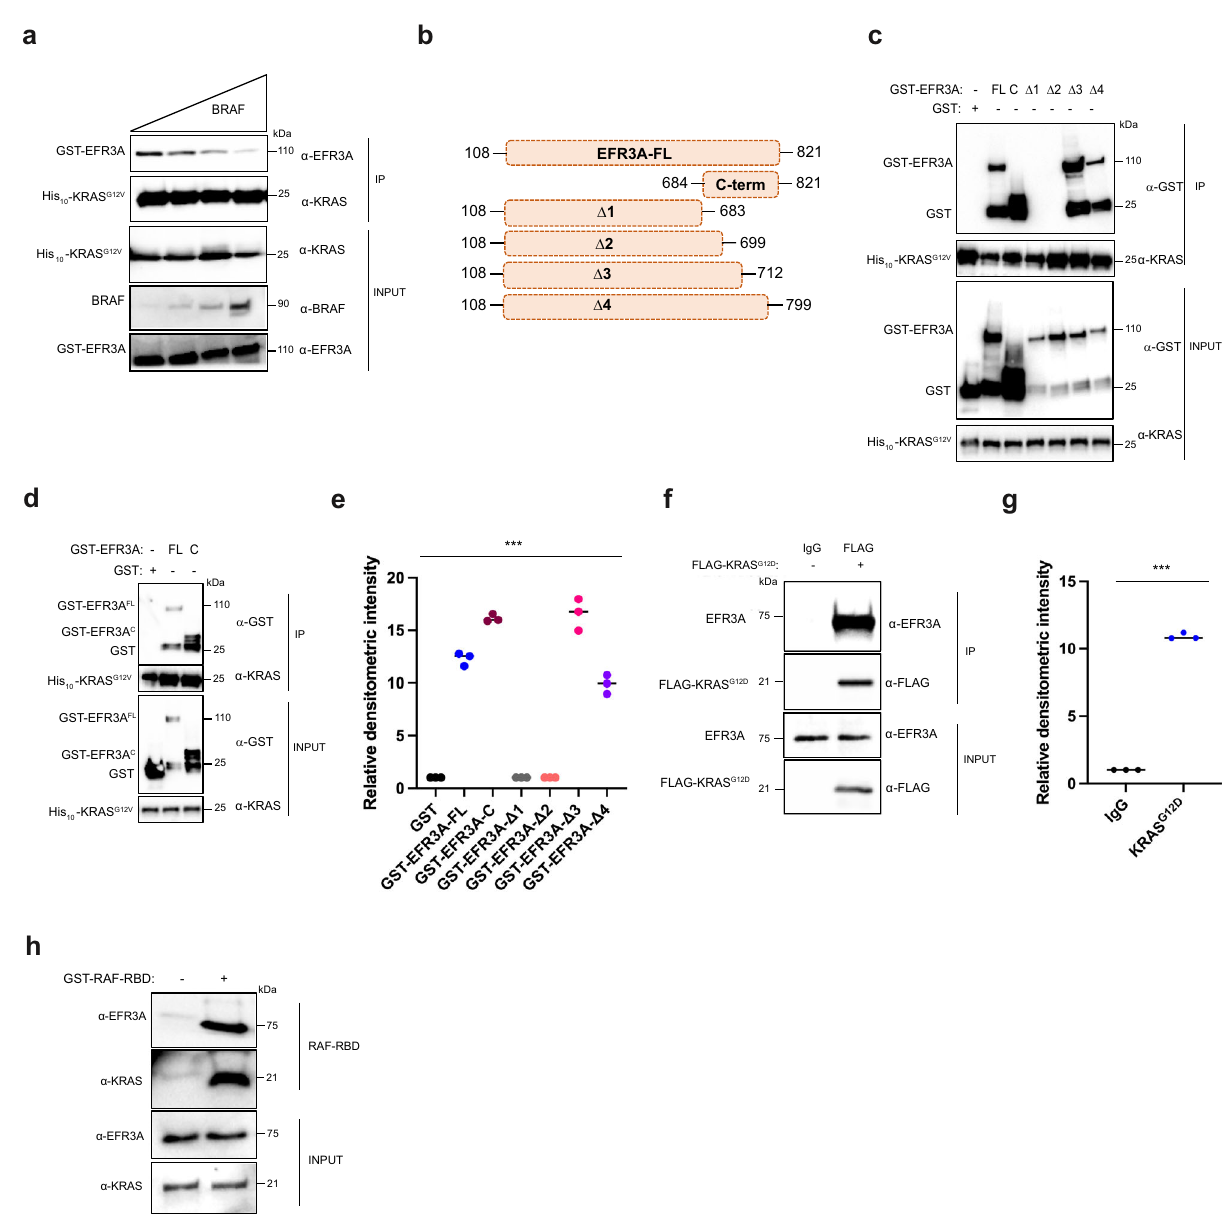
Fig. 5 EFR3A associates with recombinant and endogenous oncogenic RAS. a Analysis of levels of recombinant GST-EFR3A, as detected by immunoblot with an anti-EFR3A antibody, that co-immunoprecipitates (CO-IP) with recombinant His 10 -KRAS G12V (preloaded with GTP γ S) using an anti-KRAS antibody, in the presence of increasing levels of the RBD of BRAF, detected with and a BRAF-speci fi c antibody. INPUT levels are shown as loading controls. b – e A ( b ) schematic of GST-EFR3A constructs used (FL: EFR3A base construct lacking 1-107 residues, C: C-terminal fragment, Δ : C-terminal truncations of FL) and ( c , d ) the levels and ( e ) quanti fi cation thereof of the indicated recombinant GST-EFR3A proteins, as detected by immunoblot with an EFR3A-speci fi c antibody, co-immunoprecipitating (CO-IP) with recombinant His10-KRAS G12V (preloaded with GTP γ S) using a KRAS-speci fi c antibody. INPUT and IP serve as loading controls. GST serves as a negative CO-IP control. f , g Analysis of the ( f ) levels and ( g ) quanti fi cation thereof of the endogenous EFR3A, as detected by immunoblot with an EFR3A-speci fi c antibody, co-immunoprecipitating (CO-IP) with FLAG-KRAS G12D using a FLAG-speci fi c antibody when transiently expressed in 293T cells. h Levels of endogenous EFR3A bound to endogenous active KRAS, as assessed by RBD pull-down assay in AsPC-1 cells, as assessed by incubating AsPC-1 cell lysate with recombinant GST-RAF-RBD protein, followed by immunoblot with a KRAS-speci fi c antibody to detect active KRAS and an EFR3A-speci fi c antibody to detect endogenous EFR3A. INPUT and IP levels are shown as loading controls. a , c – h Representative of 3 biological replicates. Replicate experiments and full-length gels are provided in Supplementary Fig. 12. Signi fi cance values calculated by one-sided student ’ s t test for ( e , g ): *** p < 0.001. Speci fi c p values for ( e ) are 0.00052 (FL), 0.00035 (C), 0.00011 ( Δ 1), 0.00014 ( Δ 2), 0.00056 ( Δ 3), and 0.00034 ( Δ 4) and ( g ) is 0.00087. Targeting KRAS to the plasma membrane by an alternative illustrates that proteins ectopically expressed on the plasma anchor rescues the loss of EFR3A . The above observations are membrane do not always co-localize on the nanoscale. Collec- tively these data support the recruitment of EFR3A to activated consistent with a model whereby activated KRAS binds EFR3A, KRAS increasing the retention and nanoclustering of KRAS at the which retains KRAS at the plasma membrane to signal. A direct plasma membrane. test of this hypothesis is that maintaining KRAS at the plasma NATURE COMMUNICATIONS| (2021) 12:5248